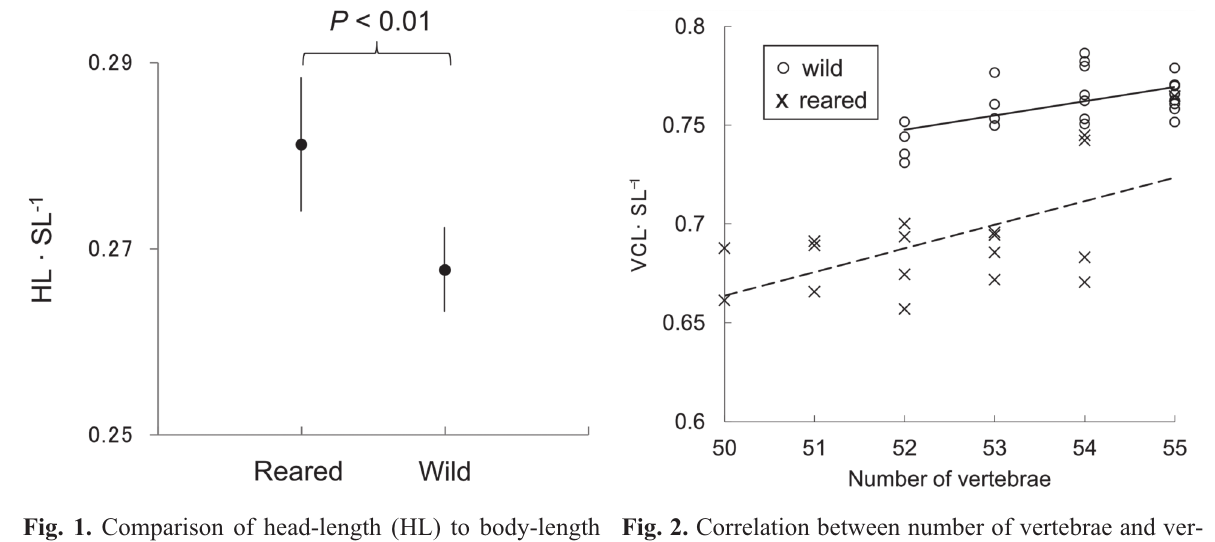
Fig. 1. Comparison of head-length (HL) to body-length (SL) proportion of hatchery-reared- (reared) ( n = 19) and wild ( n = 20) Pacific herring, Clupea pallasii